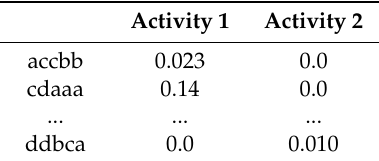
Table 1. Example of the weight matrix generated by